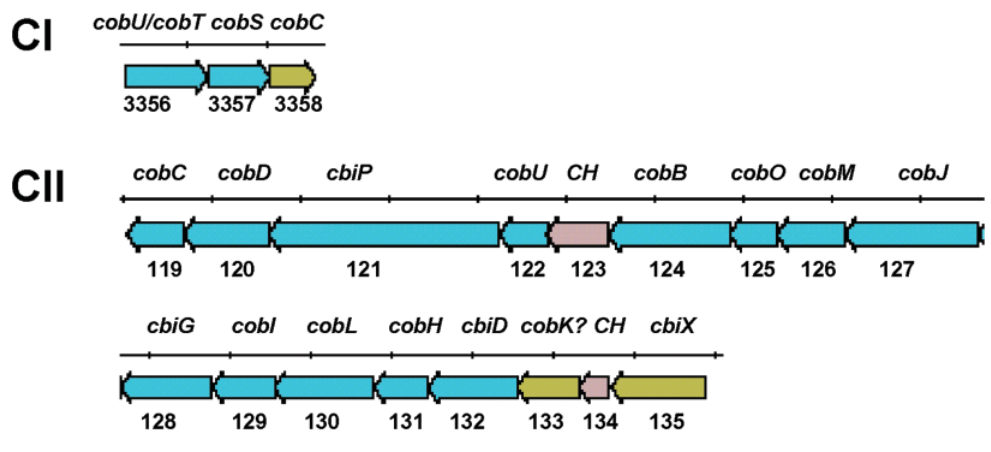
Figure 3. The cobalamin biosynthetic pathway of Leptospira interrogans . Genetic organization of the cobalamin biosynthetic locus in the two chromosomes (CI and CII) of L. interrogans serovar Copenhageni.